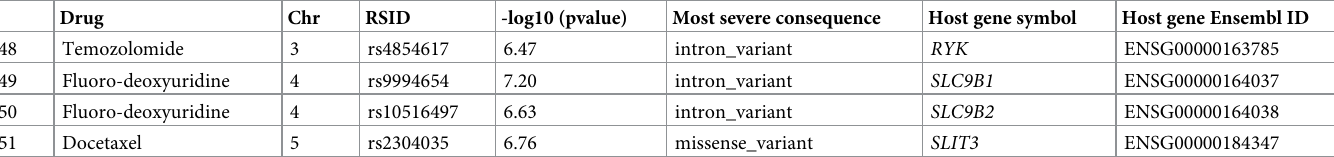
Variants in or close to the nuclear factor of activated T-cells 5 ( NFAT5) and NAD(P)H qui- none dehydrogenase 1 ( NQO1) genes (located next to each other on chromosome 16) had the most consistent association with response across 44 anticancer treatments. Six unique SNPs in or close to the NFAT5 gene were associated with response to erlotinib, trametinib, and the pac- litaxel + epirubicin combination treatment, and two unique SNPs in the NQO1 gene were associated with drug response to one or more of arsenic trioxide, erlotinib, trametinib, and the paclitaxel + epirubicin combination treatment (Table 2). The most significant association was for SNP rs12447326 (p-value = 6.78e -10 ) in the NFAT5 gene on chromosome 16 with response to erlotinib. Fig 1 shows a Manhattan plot for associa- tions of SNPs with response to erlotinib. Manhattan plots for the other drug treatment GWAS are included in Fig A in S1 Text. The chromosome 16 peak centered on the NFAT5/NQO1 locus has seven SNPs that surpass the genome-wide significance level (the solid black horizon- tal line), including sentinel SNPs for each gene. Fig 2A and 2B show zoomed-in regional gene